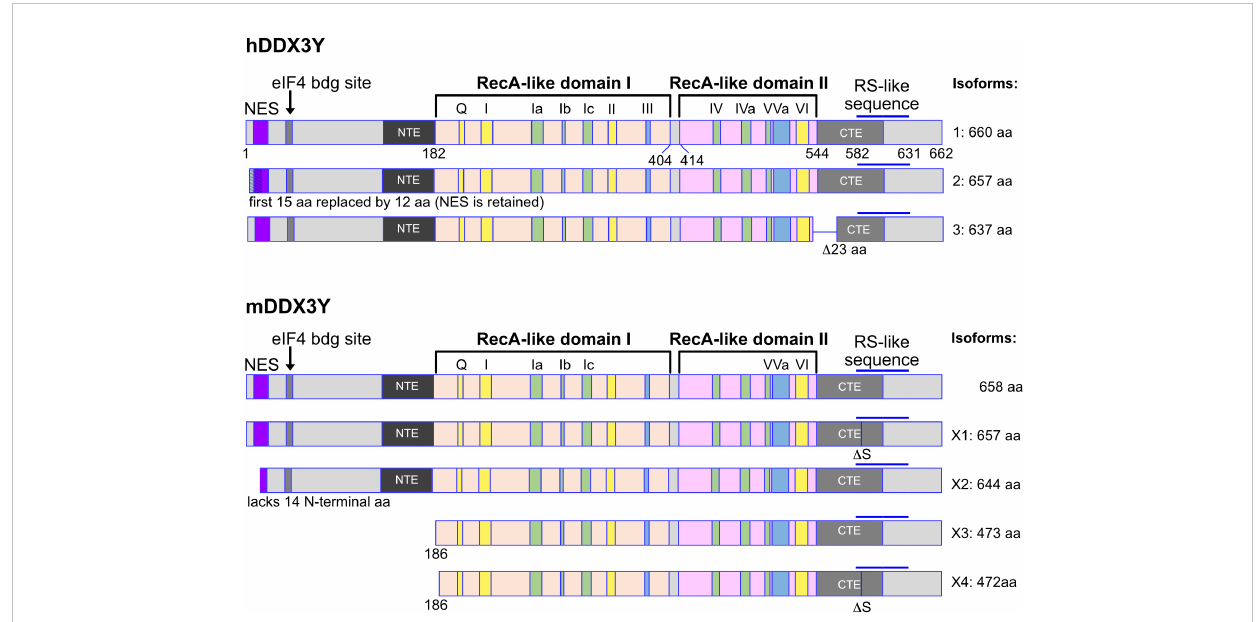
FIGURE 2 Human and murine DDX3Y isoforms. Shown are the different isoforms of the human (upper part) and murine (lower part) DDX3Y proteins. The inverse situation is found compared to the human and murine DDX3X protein isoforms. Here, the isoforms X2 to X4 of DDX3Y in mouse lack a functional nuclear export sequence (NES). These murine DDX3Y isoforms may therefore also be localized in the nucleus, whereas the human DDX3Y proteins are likely to be mostly